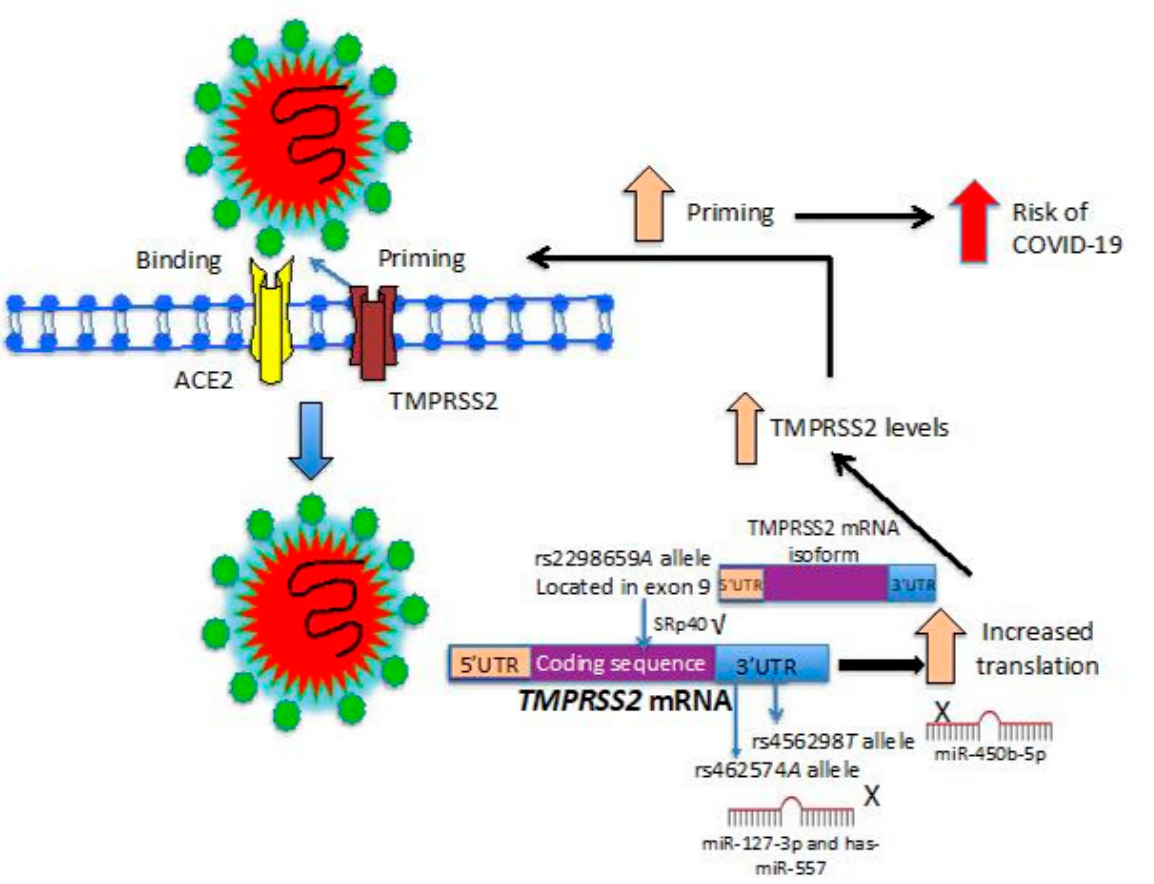
Figure 3. Hypothesis based on in-silico analysis of three SNPs located in the TMPRSS2 gene. TM- PRSS2 can cleave the S protein and thus facilitate the entry of SARS-CoV-2 into the cell. According to in-silico analysis, the A allele of rs2298659 G/A could create a binding site for SRp40, a splicing protein involved in the generation of protein isoforms (20 mRNA isoforms have been